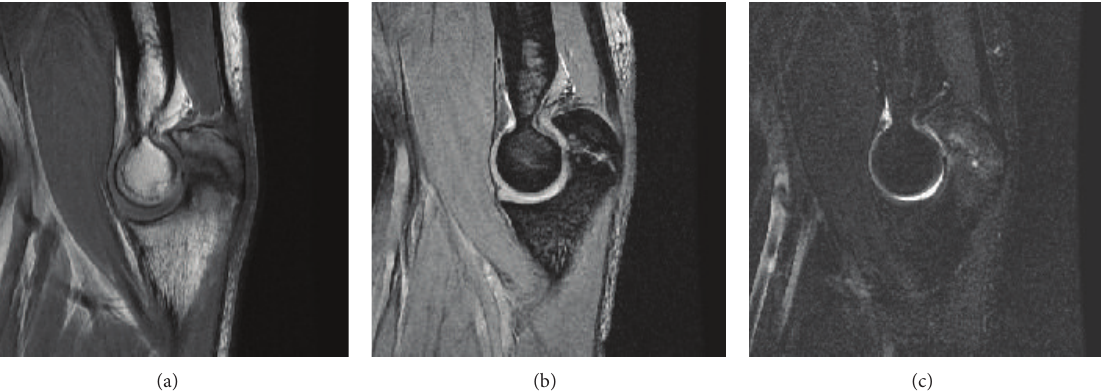
Figure 1: Sagittal T1-weighted (a) and T2-weighted (b) magnetic resonance (MR) images of the right elbow showing abnormal intensity in the olecranon physis. Sagittal T2-weighted MR image with fat saturation (c) of the right elbow showing high intensity in the intramedullary